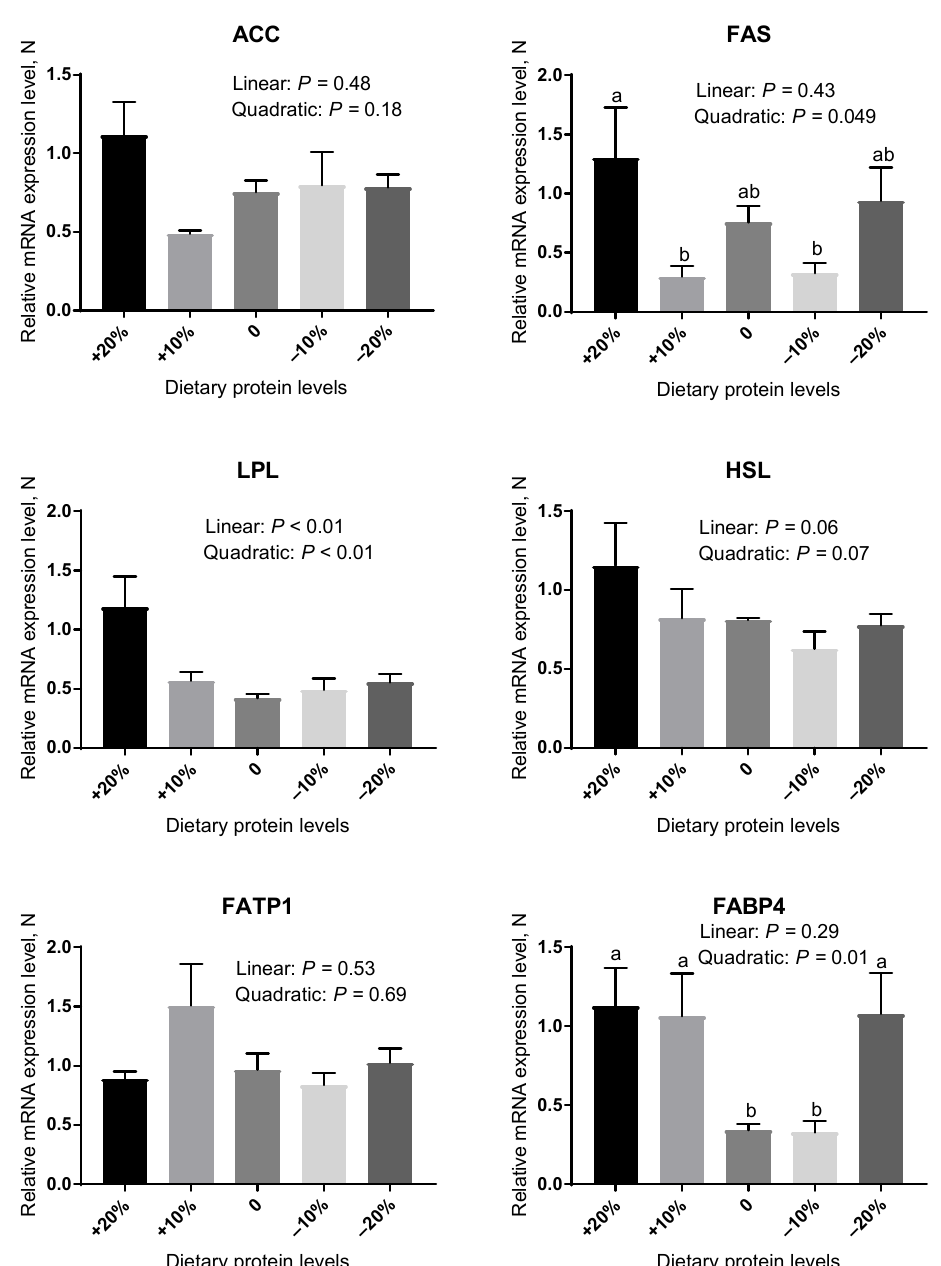
Figure 1. The relative mRNA expression level of genes related to lipid metabolism in the DSA of pigs fed different protein levels. Values are means, with their standard errors represented by vertical bars. a,b Values ( n = 6) within a row with different lowercase letters differ significantly ( p < 0.05) by the Kruskal-Wallis test.